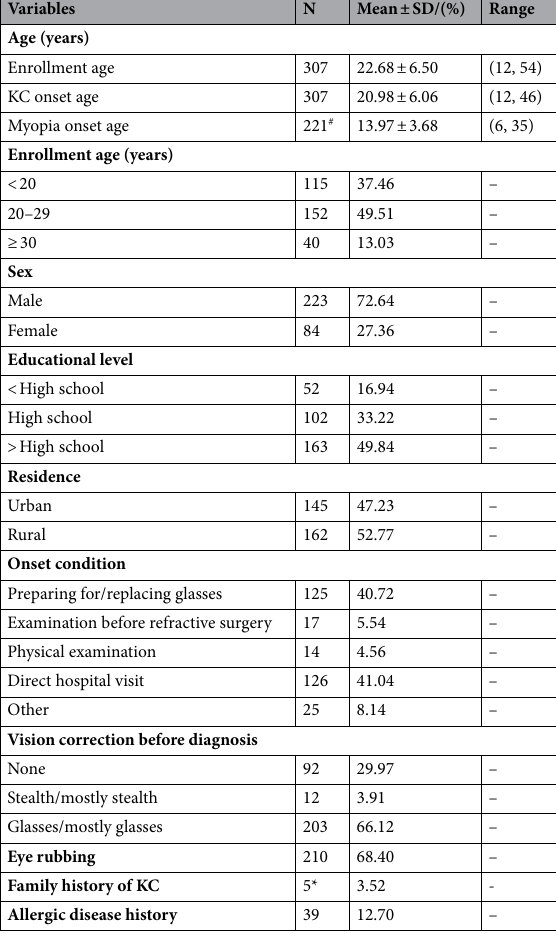
Table 2. Demographic characteristics of 307 patients. # A total of 221 KC patients had a history of myopia before diagnosis. *Family members of 142 KC patients were examined.